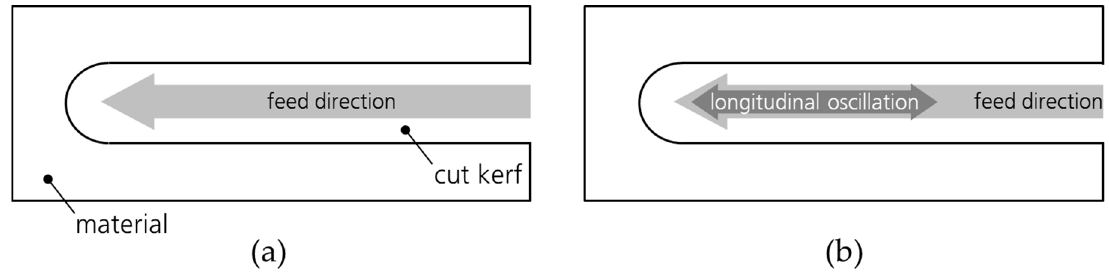
Figure 2. Schematic beam movement of ( a ) Static beam shaping; ( b ) Longitudinal, linear beam oscillation.